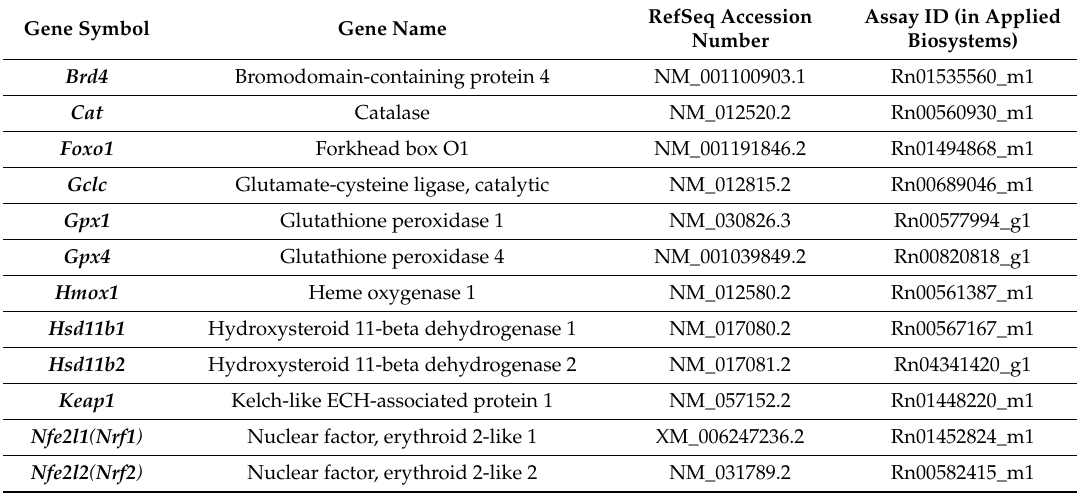
Table 1. List of Taqman TM gene expression assays used for quantification of mRNA levels. Gene